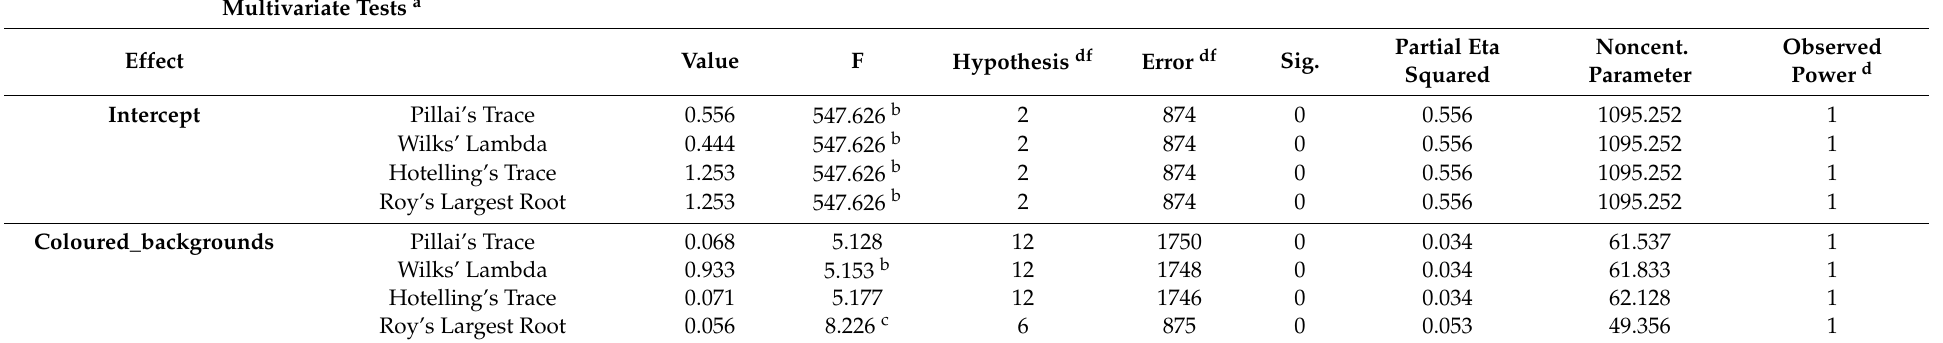
Table A4. Multivariate Tests of People’s Responses to Colours—General Effects.